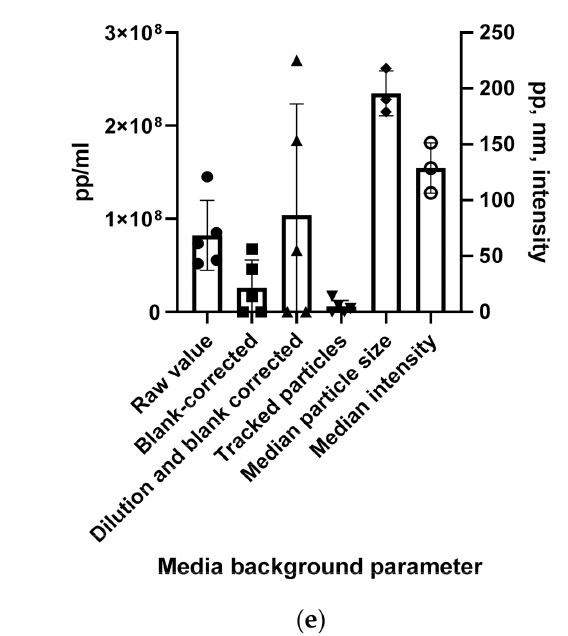
Figure A1. Requirements for measurements were studied by measuring a 2-fold lentivirus dilution series: ( a ) the effect of the measurement duration (number of blocs) on the relative error of the particular bloc. ( b ) Blank (PBS) repeatability was tested by two operators on different days by performing several blank measurements. Normal device cleaning was performed after the measurements. Operators’ averages are shown in the figure with dotted lines. ( c ) Intermediate blank average was followed by recording either the daily blank result or the average in case of multiple measurements. Intermediate average is shown in the figure as dotted line. ( d ) The minimum number of tracked particles was studied by measuring different LV dilutions and calculating the relative error after each bloc against the final result. An exponential one phase decay equation for with 95% CI is shown as a black line. ( e ) The level particles of cell culture media background were studied in HEK-derived cells 2-3 days after seeding on two separate